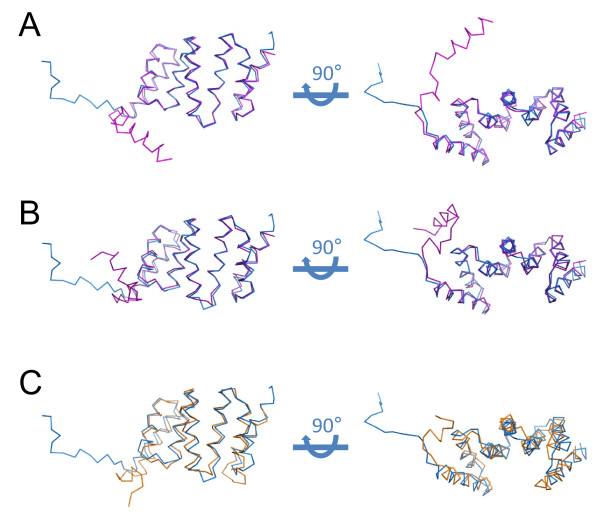
Superposition of Monomers from Class II Chaperone Structures. (A) Orthogonal views of superposition by Local-Global Alignment for the IpgC10-155 monomer (blue) with chain A from the published structure of IpgC1-151 (magenta)[8]. (B) Orthogonal views of superposition by Local-Global Alignment for the IpgC10-155 monomer (blue) with chain B from the published structure of IpgC1-151 (magenta)[8]. (C) Orthogonal views of superposition by Local-Global Alignment for the IpgC10-155 monomer (blue) with chain A of the published structure of SycD21-163 (orange)[7]. Additional quantitative descriptions of the quality of each superposition may be found in Table 2